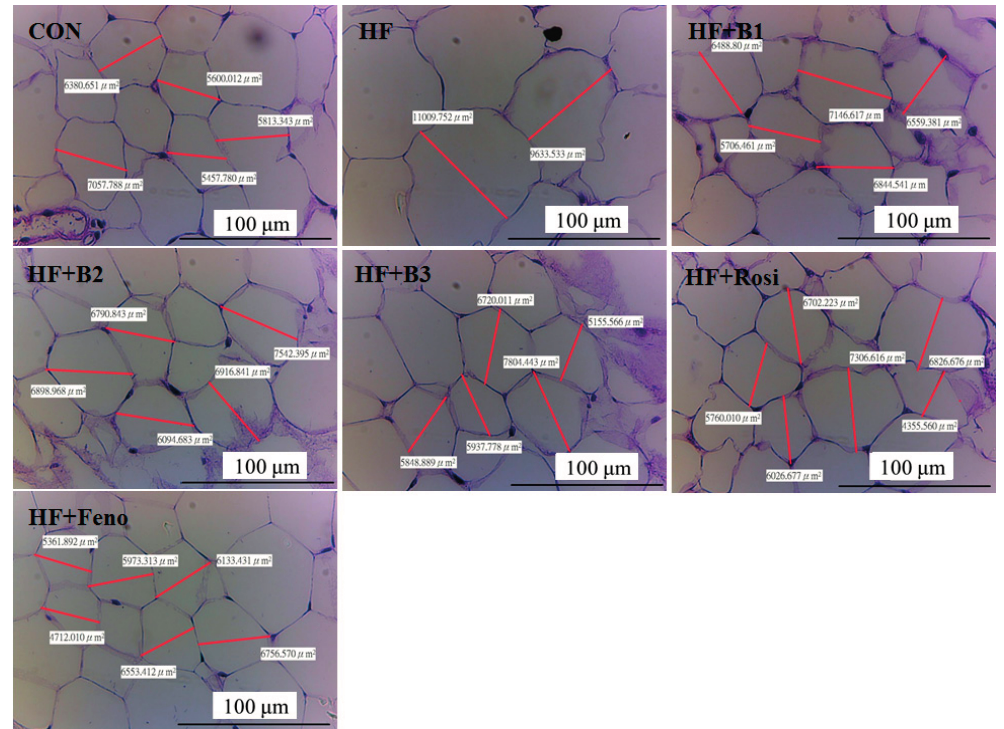
Figure 3. Pathological effects of ( − )-epicatechin-3- O - β - D -allopyranoside (BB) on epididymal white adipose tissue (WAT) in the low-fat (CON), high-fat (HF; high-fat diet control), HF + B1, HF + B2, HF + B3, or HF + Rosi, and HF + Feno groups. Pictures of